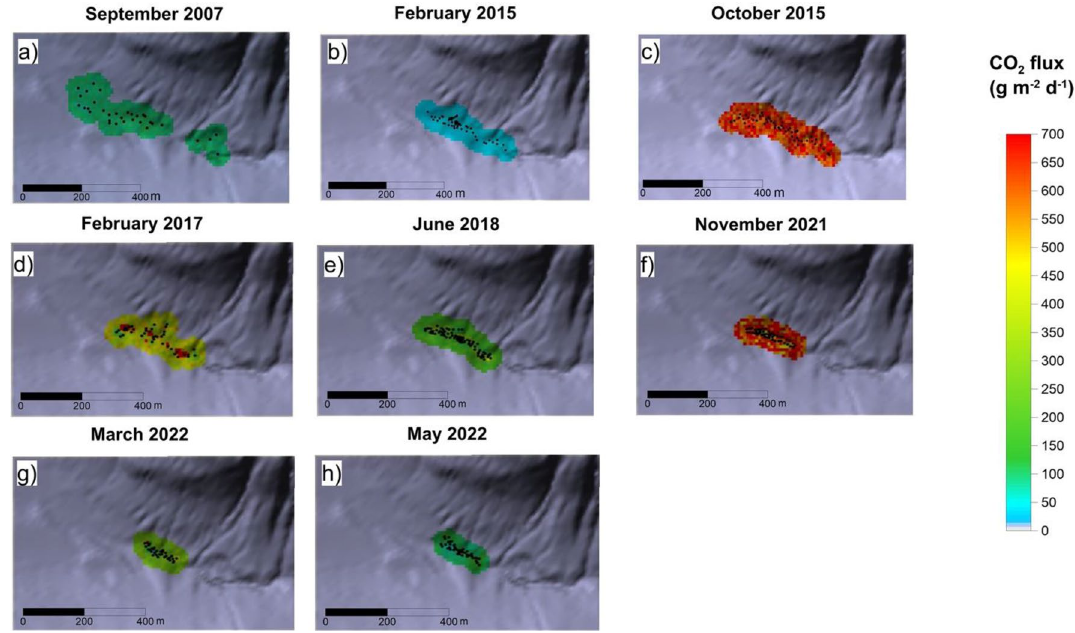
Figure 3. Soil CO 2 flux maps of Palizzi area (in g m −2 d −1 ) obtained by the sGs from September 2007 to May 2022. The black dots are measurement points. The maps were generated by Surfer Software Version 11.6.1159 Surface Mapping System (http:// www. golde nsoft ware. com).